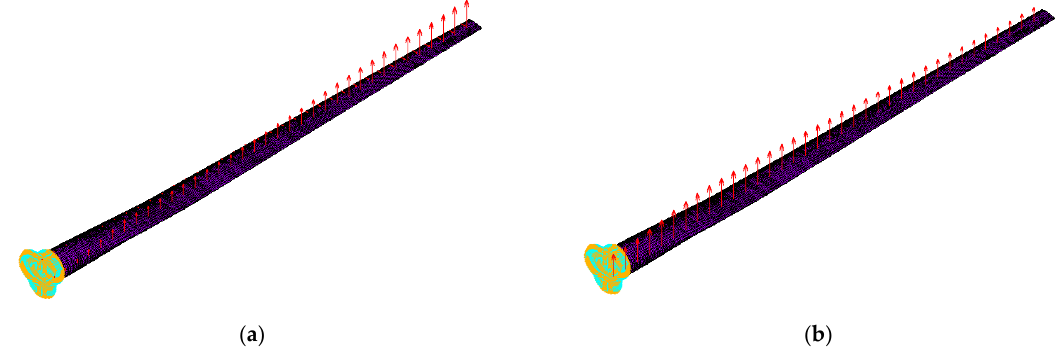
Figure 8. ( a ) Operational load distribution of the FEM model; ( b ) Ultimate load distribution of the FEM model.